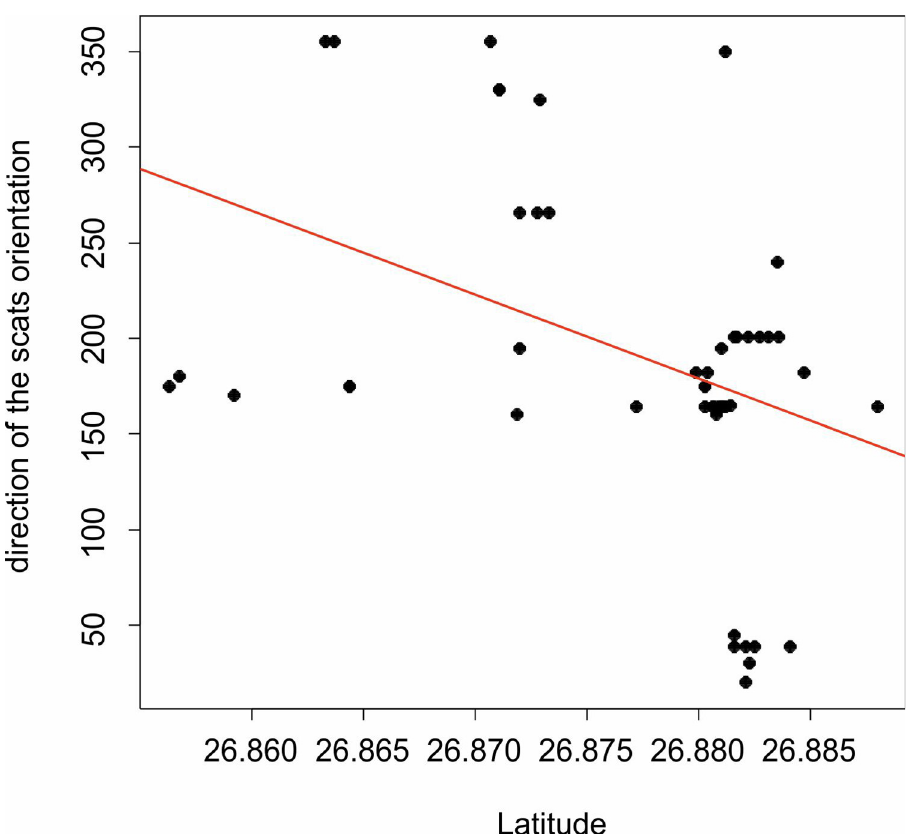
Fig 5. Effect of latitude on orientation of Leopards ( Panthera pardus fusca ) during defecation. The positioning of the body during defecation is related to the location of the leopard. Individuals observed more northwards, positioned their bodies more north-south axis than leopards further